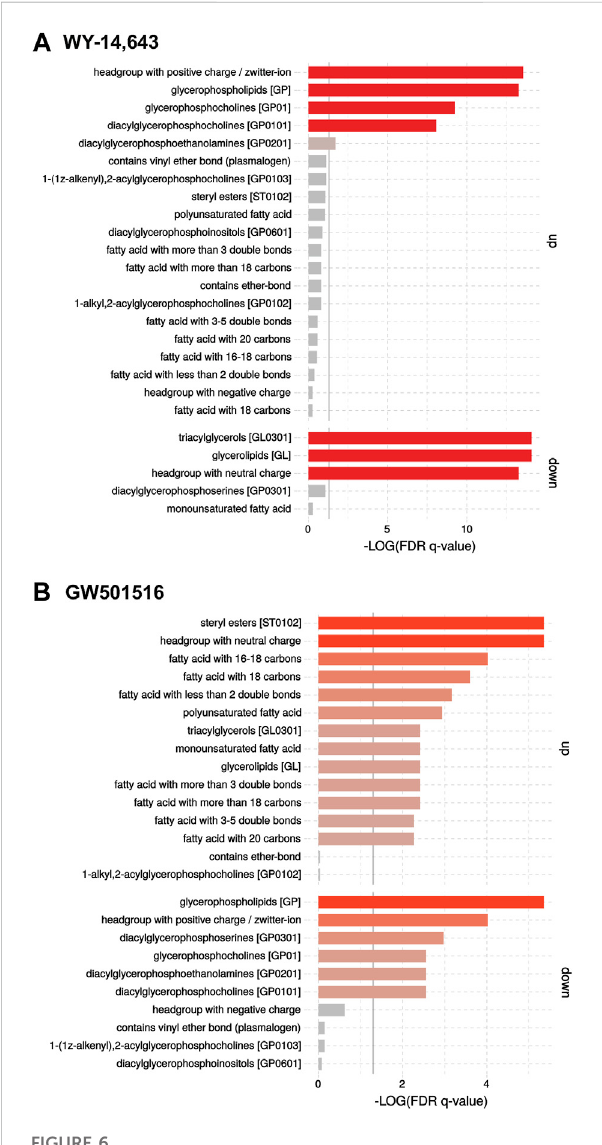
Enrichment analyses of FIA-HRMS lipidomic data in cod plasma following treatment with (A) WY-14,643 and (B) GW501516. The analyses were performed on normalized targeted lipidomics data, using the LION/web tool (Molenaar et al.,